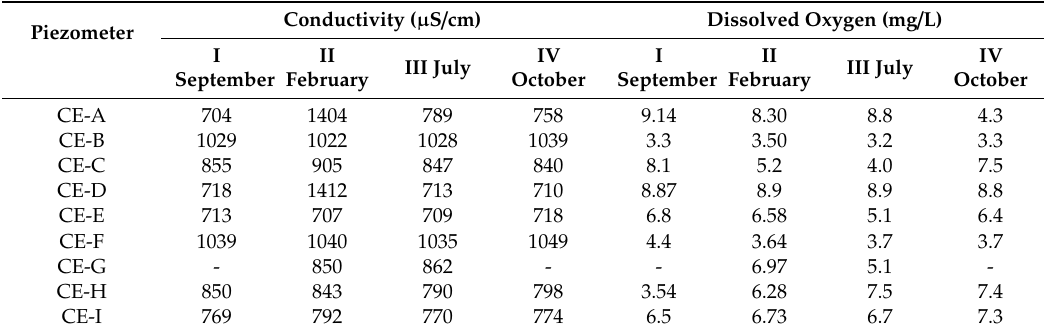
Table 3. Conductivity ( µ S / cm) and dissolved oxygen (mg / L) found in each piezometer (CE-A, CE-B, CE-C, CE-D, CE-E, CE-F, CE-G, CE-H, and CE-I) at each sampling campaign.